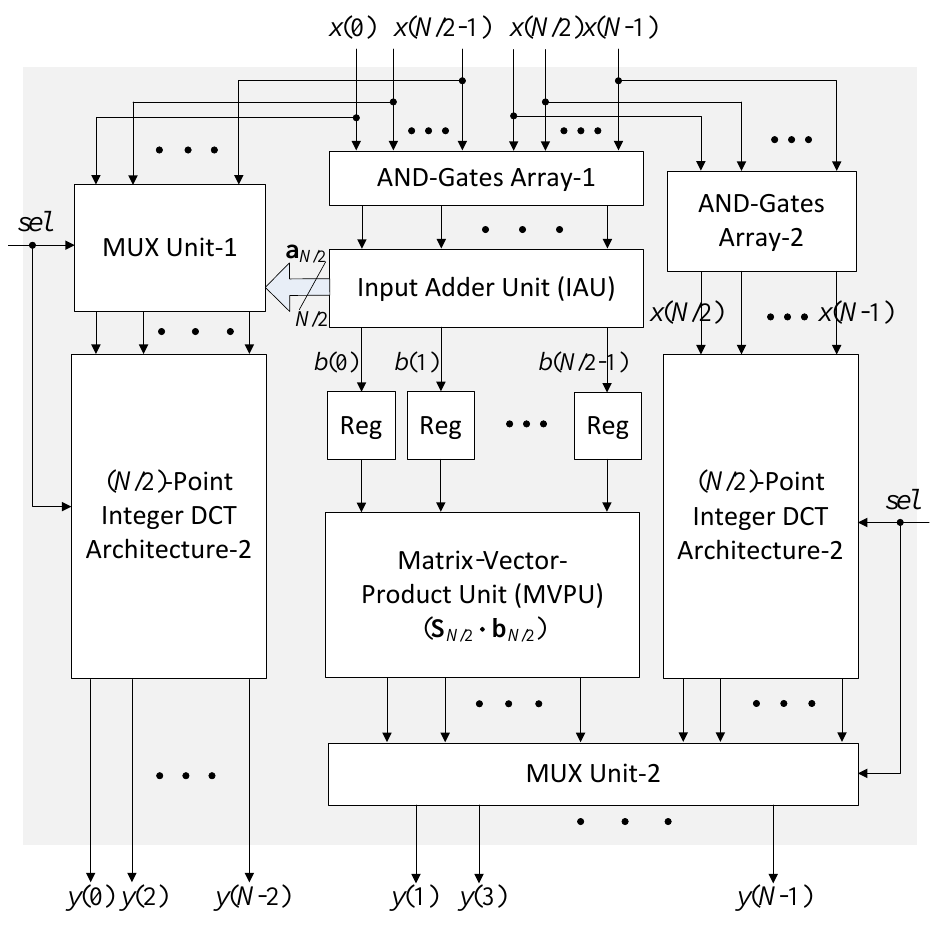
Figure 2. Proposed Architecture-2 for N = 8, 16, and 32. The four-point integer DCT architecture is same as the one shown in Figure